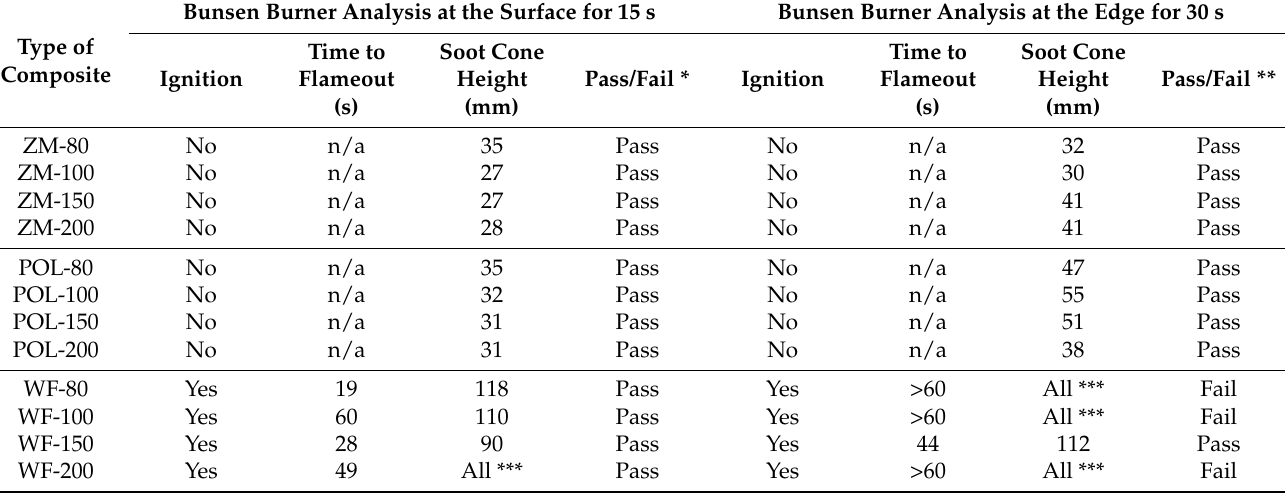
Table 5. Single flame test results for produced seagrass-based and WF insulation